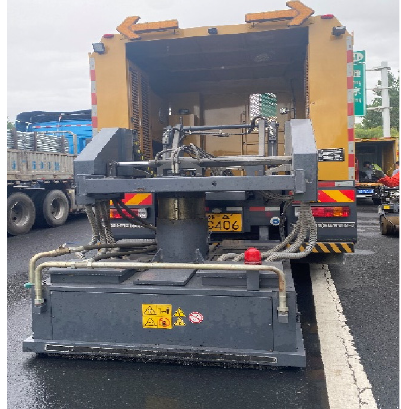
Figure 5. Pavement heating car.